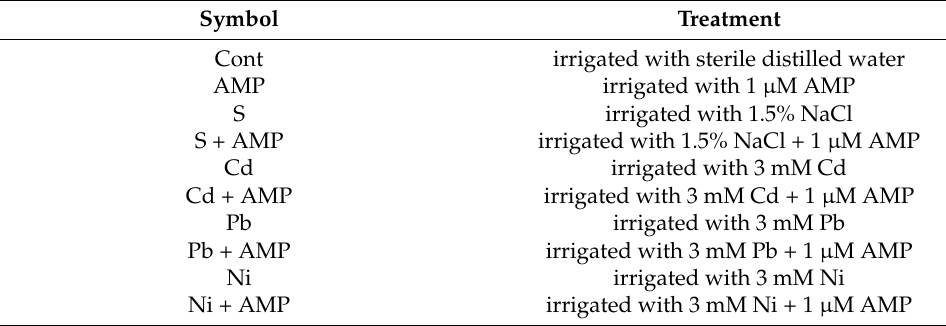
Table 3. Experimental work